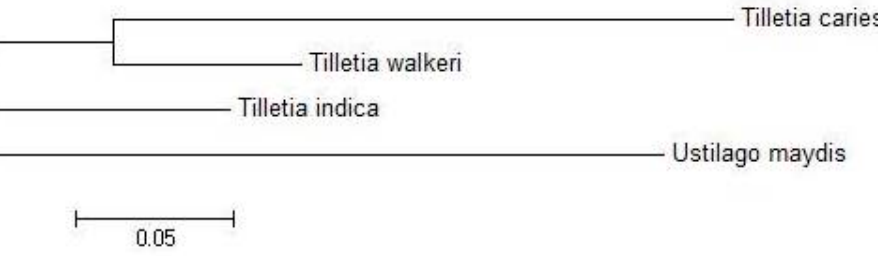
Figure 3. Comparative phylogeny with Tilletia caries, Tilletia walkeri and Ustilago maydis .